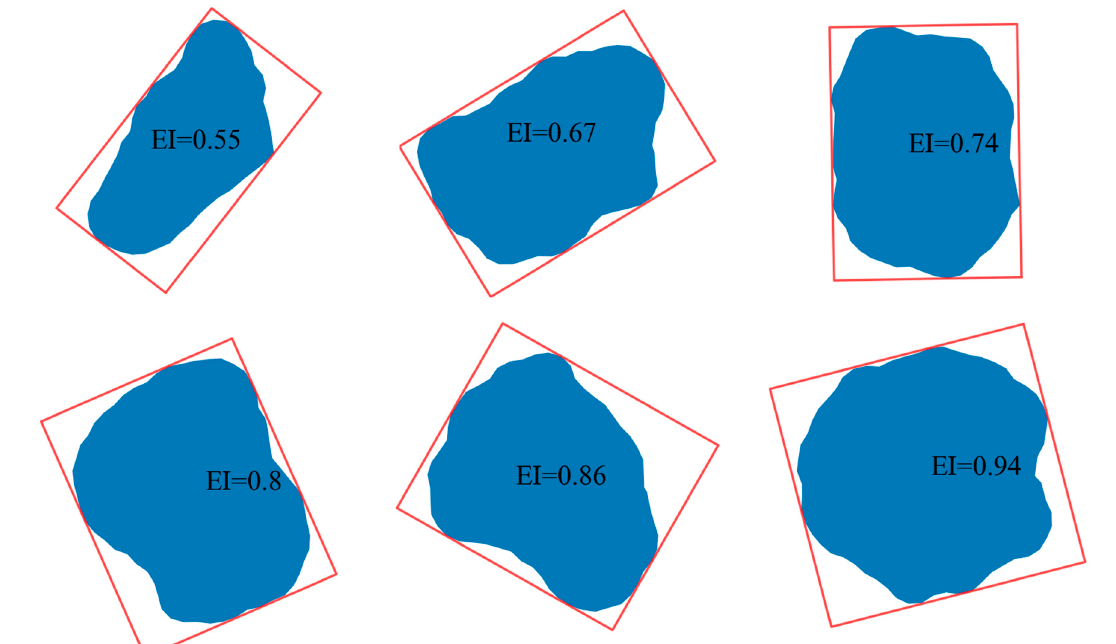
Figure 5. Particles with different elongation index.